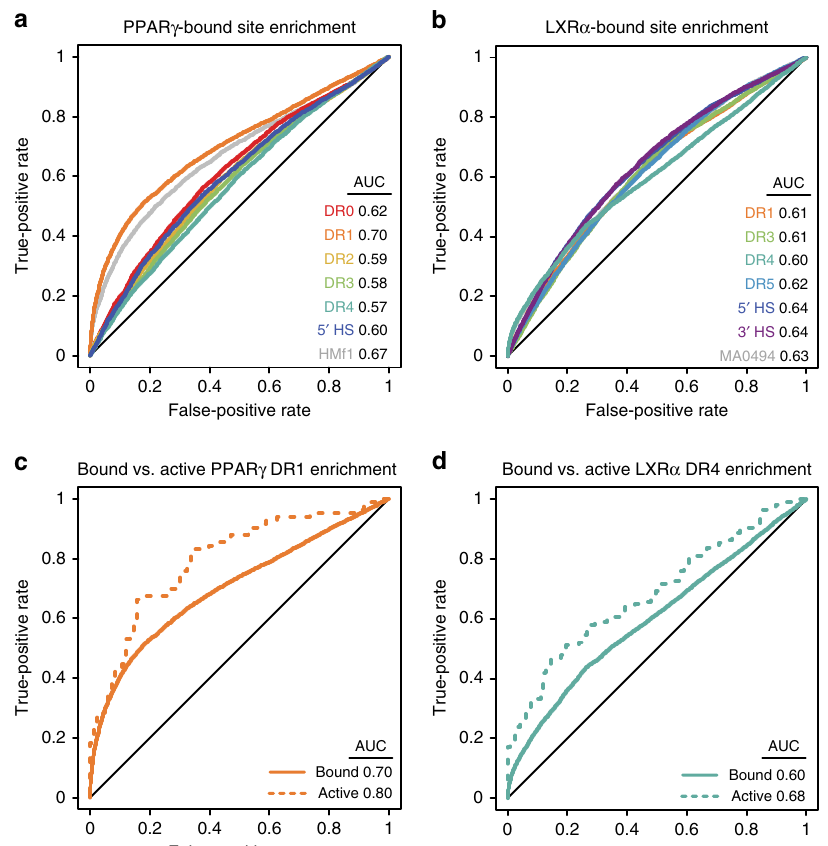
Fig. 6 Genomic enrichment of NR-binding motifs. a Receiver-operating characteristic (ROC) curves for PPAR γ motif enrichment in ChIP-seq data. ROC curves and area under the curve (AUC) values for different PBM-derived NR-binding models are shown, along with the results for best-performing published PPAR γ DR1 motif (HOCOMOCO-f1, HMf1 28 ). Motif enrichment for all models had p -values < 10 − 46 , using a Wilcoxon rank sum test with continuity correction and Bonferroni corrected for multiple hypotheses. b ROC curves for LXR α motif enrichment in ChIP-seq data. ROC curves and AUC values for different LXR α binding models are shown. Results for best-performing published LXR α DR4 motif (JASPAR MA0494.1 29 ) are shown. c ROC curves and AUC values are shown for PPAR γ DR1 motif enrichment in reproducibly-bound PPAR γ ChIP-seq peaks (solid lines, Methods), and for those peaks occurring within 10 kb upstream of differentially expressed genes (i.e., active peaks). d ROC curves and AUC values are shown for LXR α DR4 motif enrichment in reproducibly-bound LXR α ChIP-seq peaks (solid lines, Methods), and for those peaks occurring within 10-kb upstream of differentially expressed genes (i.e., active peaks). Source data are provided as a Source Data fi